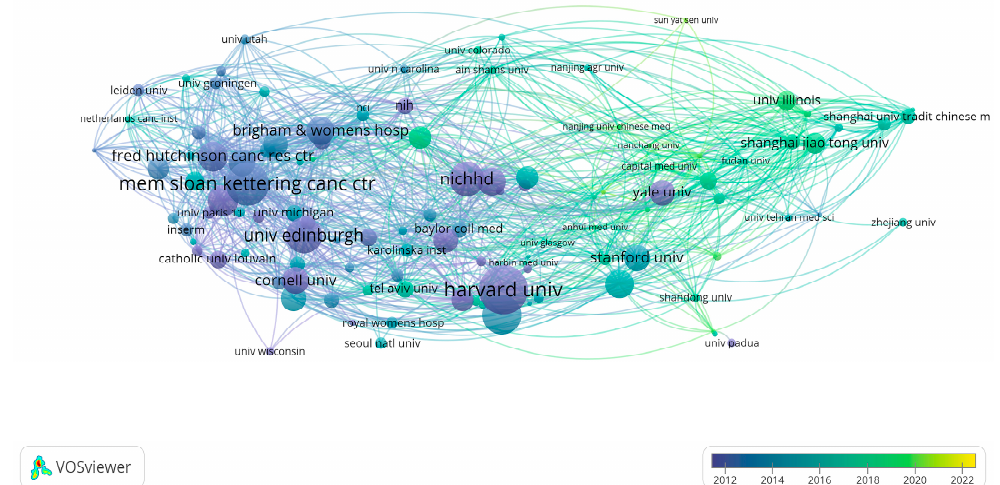
Figure 3. Organizations with citation relations shown as an overlay graph plotted with VOSviewer. The analysis method was Linlog/modularity. The weight was citations. The thickness of lines indicates the strength of the relationship. The color indicates the average published year.